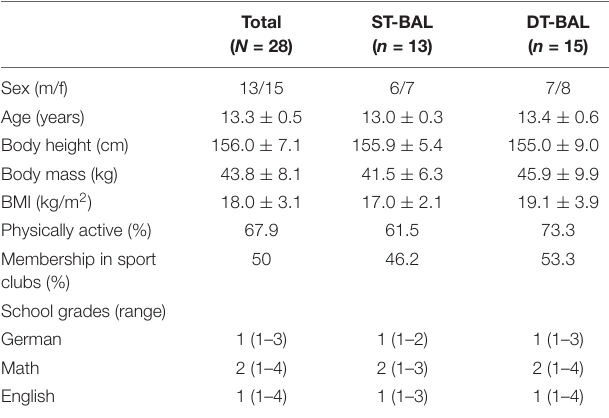
TABLE 1 | Participants’ characteristics (mean ± standard